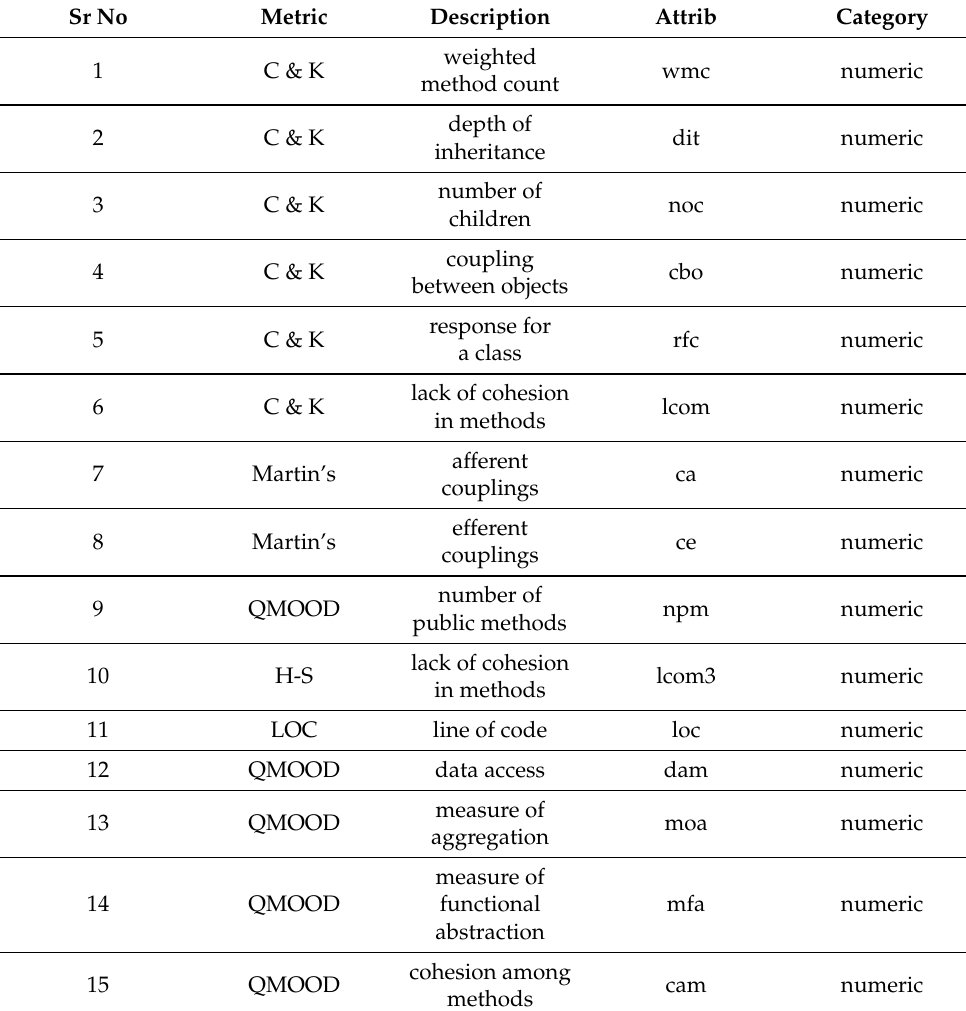
Table 3. Attribute details of the Jureczko prop